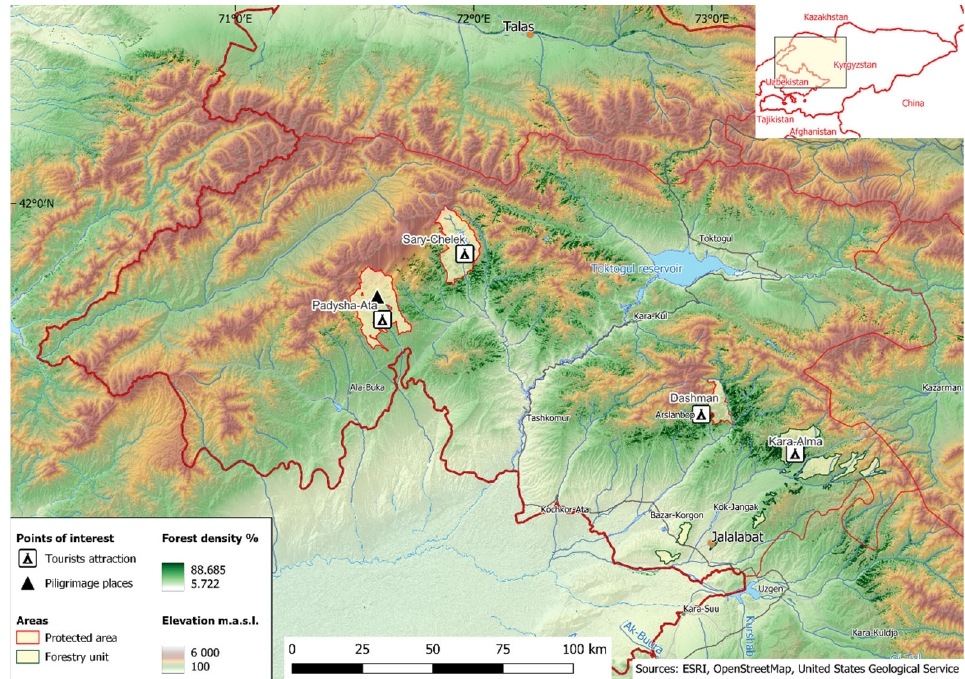
Figure 1. Study regions in Jala ‐ Abad province, Kyrgyzstan, including selected villages.